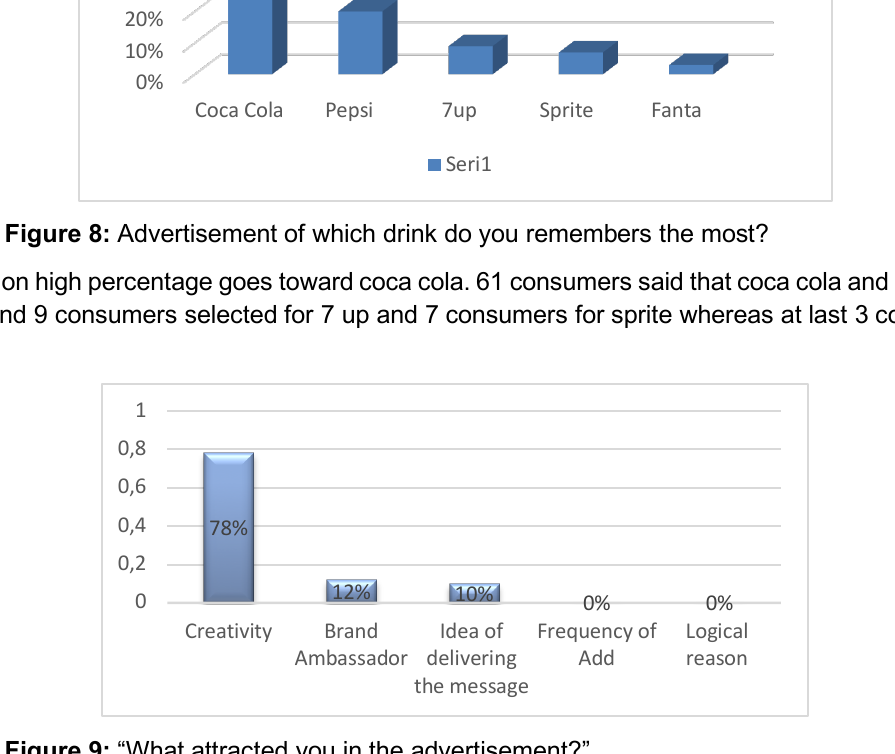
Figure 9: “What attracted you in the